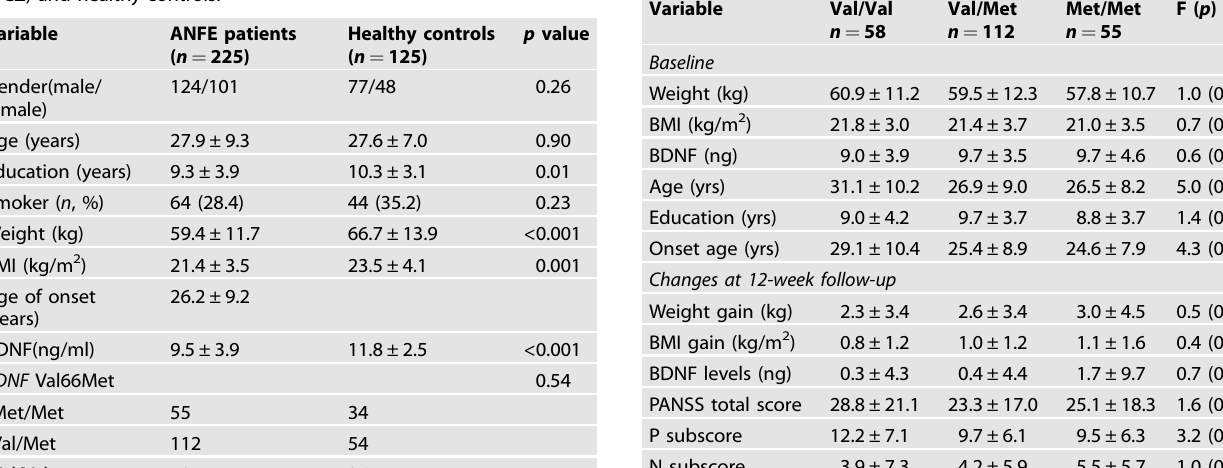
Table 1. Demographic characteristics, clinical data, and BDNF levels in antipsychotics-naive fi rst-episode (ANFE) patients with schizophrenia (SCZ) and healthy controls.